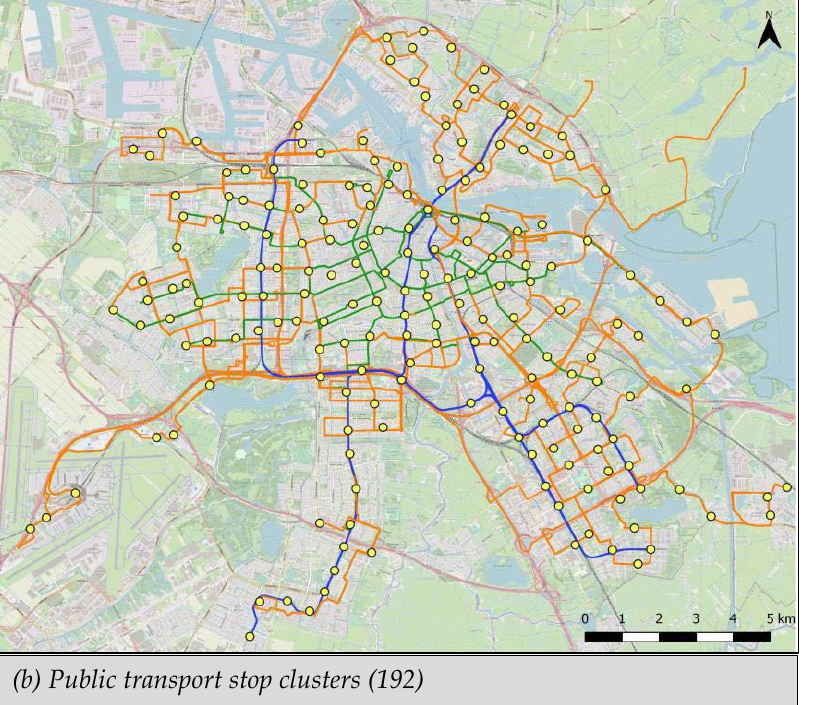
Figure 5. Public transport stops (a) and stop clusters (b) in Amsterdam (Base map and data from OpenStreetMap and OpenStreetMap